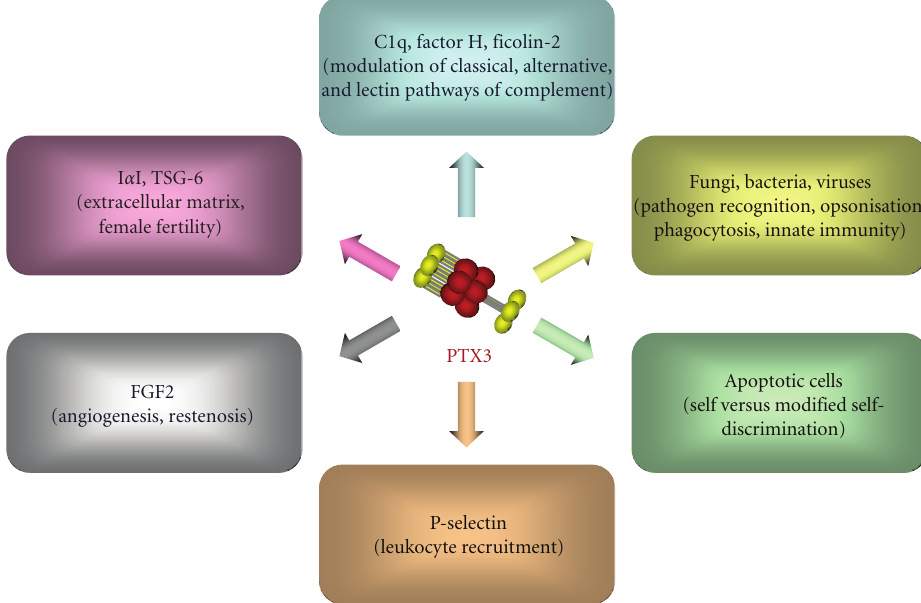
Figure 2: Schematic representation of the most relevant PTX3 ligands, classified based on the functional implications of their interaction with the long